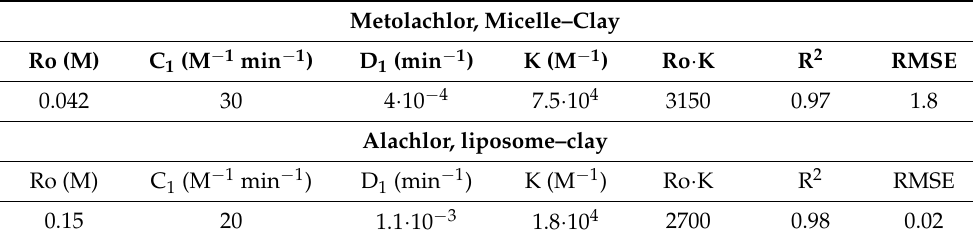
Table 5. Calculated parameters by the adsorption–convection model for the fit of experimental data of metolachlor and alachlor filtration by ODTMA– and DDAB–clay